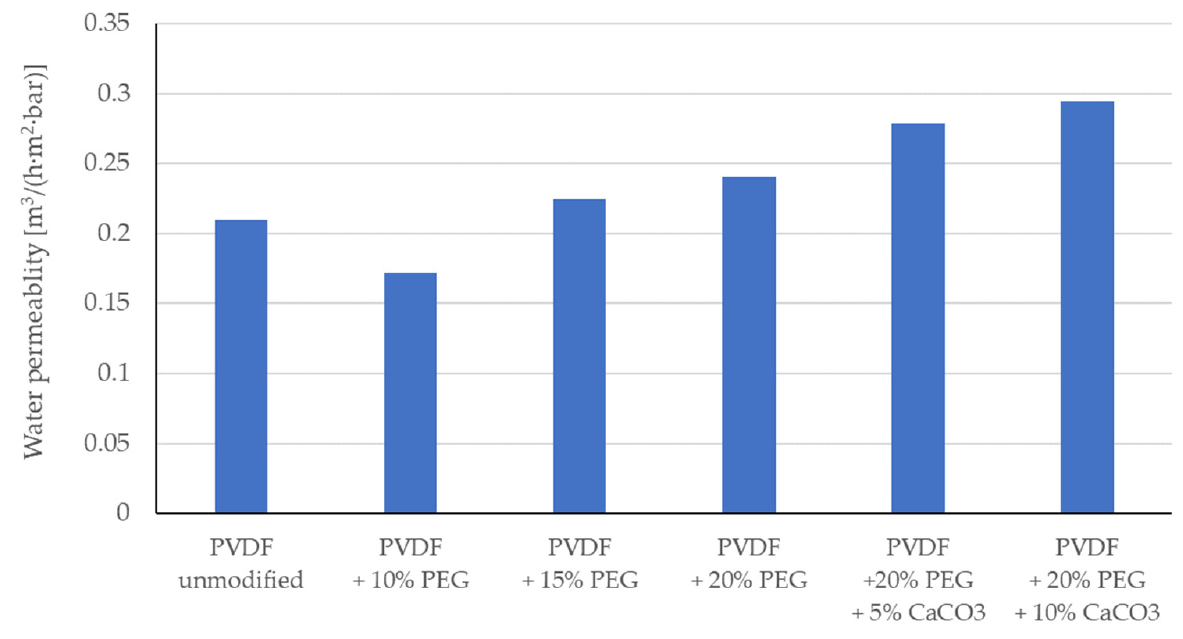
Figure 1. Water permeability results for the membranes tested. Figure 1 . Water permeability results for the membranes tested. Table 2. Contact angles of the inner and outer surfaces of Table 2 . Contact angles of the inner and outer surfaces of membranes.